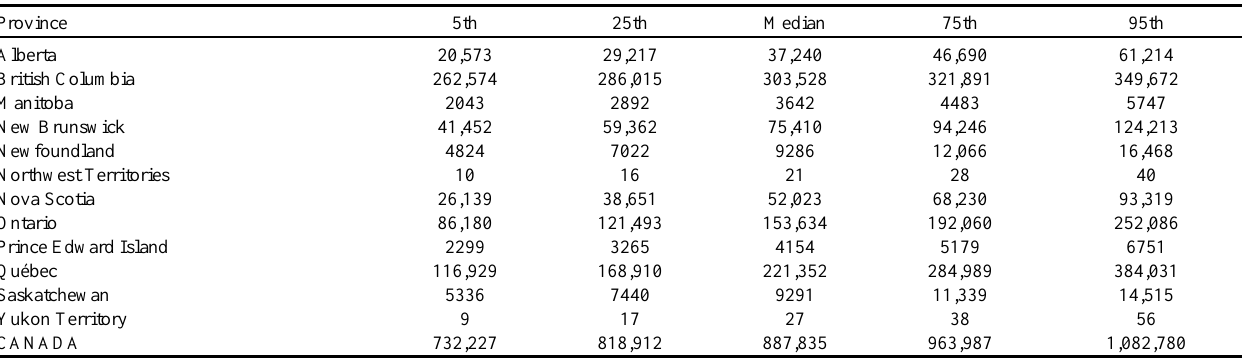
Table 7 . Estimated reduction in potential adult recruits into the migratory bird population due to the loss of nests owing to forestry operations occurring during the migratory bird breeding season. Estimates represent percentiles of the estimated distribution.